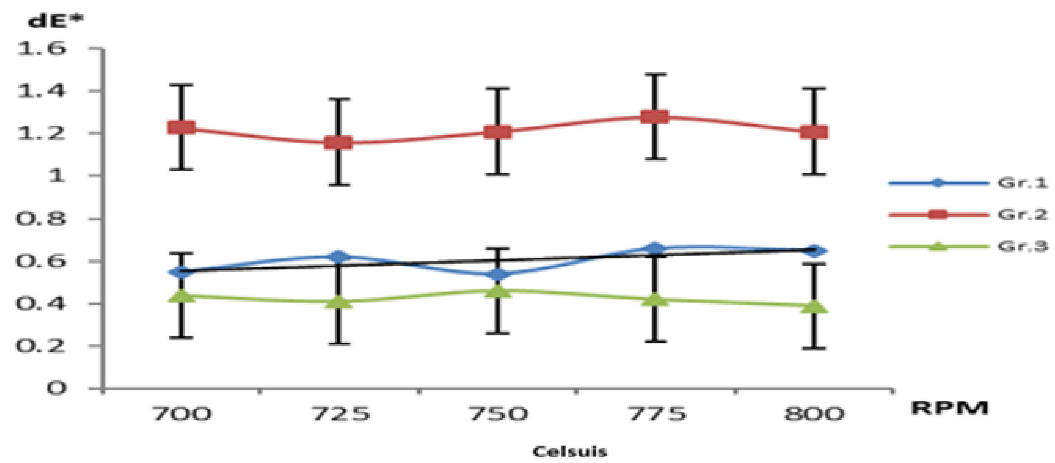
Figure 2. Temperature effects on dE* for Grade 1, Grade 2 and Grade 3.